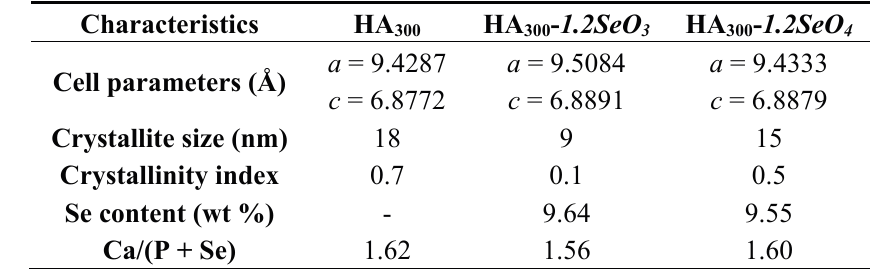
Table 1. Various parameters of the studied samples. The unit cell parameters a and c (in Å), crystallinity index and crystallite size (in nm) were calculated from the PXRD patterns using Rietveld analysis. Chemical composition of the samples was studied using WD-XRF